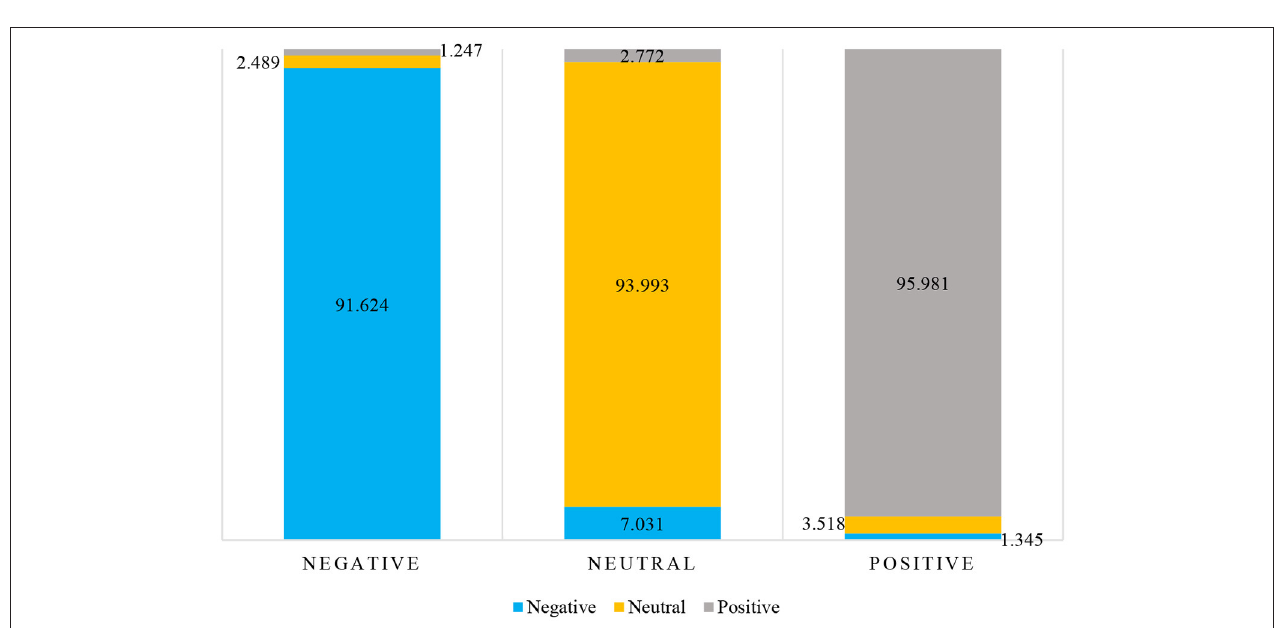
FIGURE 6 | Percentage stacked column chart of facial emotion recognition confusion